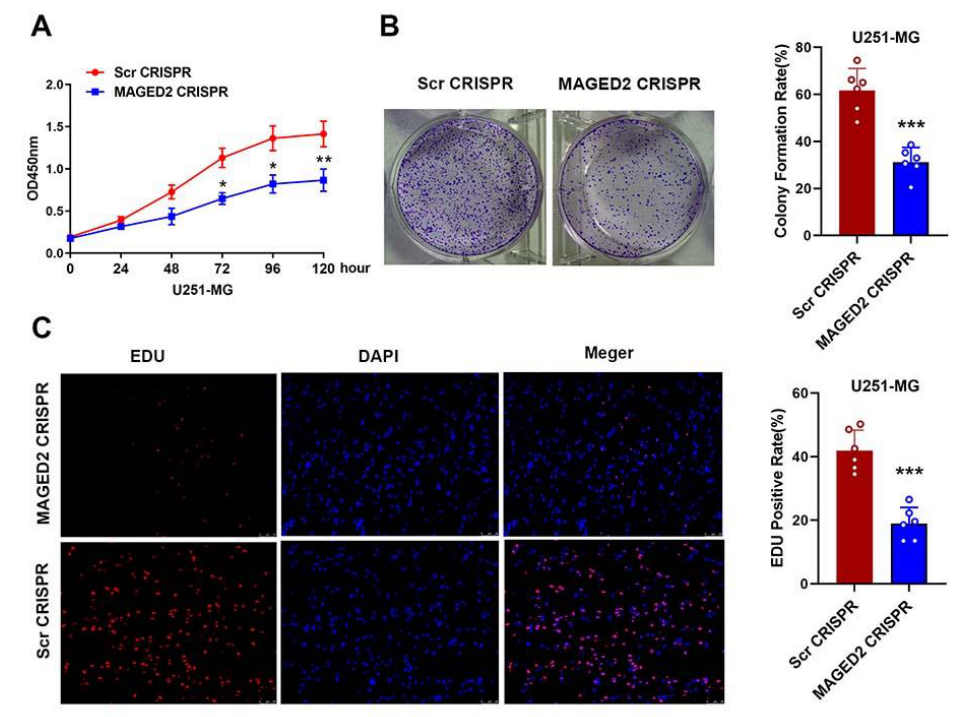
Figure 6. Glioma cell proliferation and colony formation are inhibited when MAGED2 is downregulated. ( A ) MAGED2 inhibition decreases the growth of glioma U251-MG cells in CCK-8 tests. ( B ) Colony formation also showed that the proliferation of U251-MG cells significantly reduced when MAGED2 is inhibited. ( C ) EdU tests indicate that downregulation of MAGED2 inhibits the proliferation of glioma U251-MG cells. * p < 0.05, ** p < 0.01, *** p < 0.001 compared with the Scramble CRISPR group; n = 6/group.